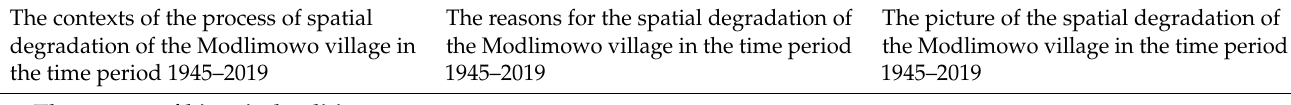
Table 1. Statement of